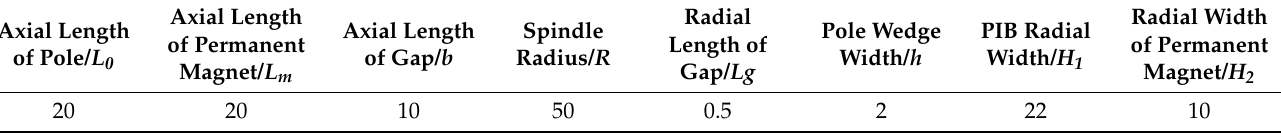
Figure 4. Partial view of MR fluid sealing device. Table 1. Dimensions of MR Fluid Sealing Device (unit: